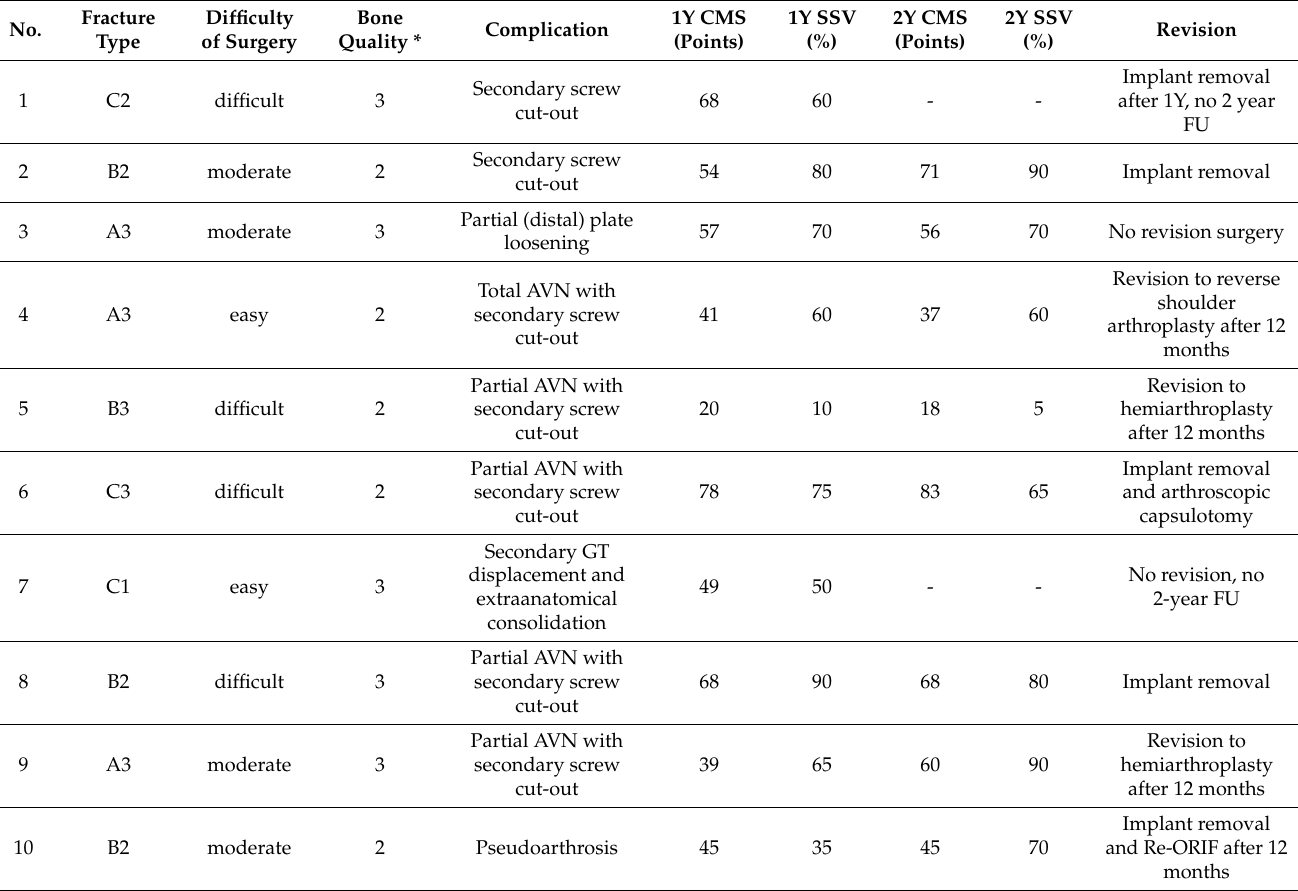
Table 3. Patients with